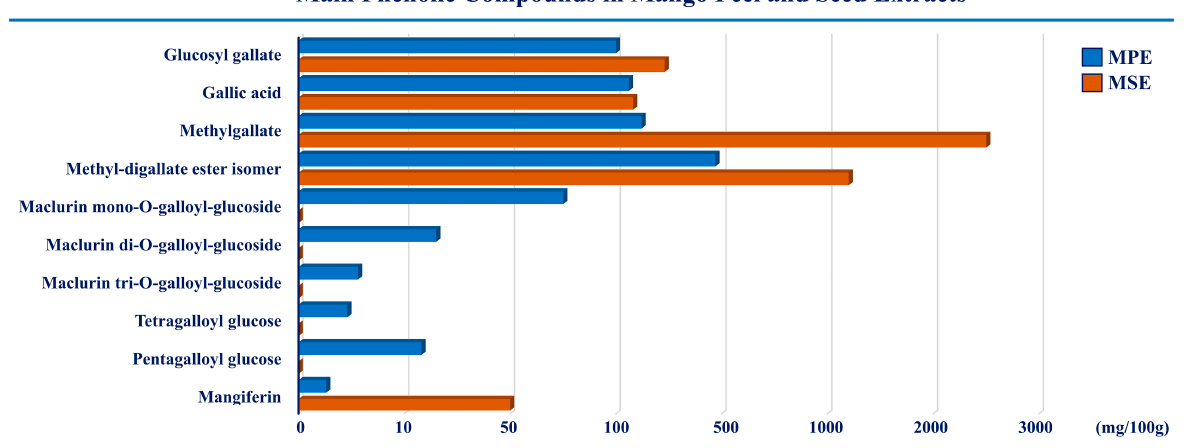
Figure 1. The main phenolic compounds in mango peel and seed extracts. The compositions of MPE and MSE were characterized by HPLC-ESI-MS analysis. Methyl-digallate ester isomer, methyl gallate, gallic acid and glucosyl gallate are the most representative polyphenols in both the